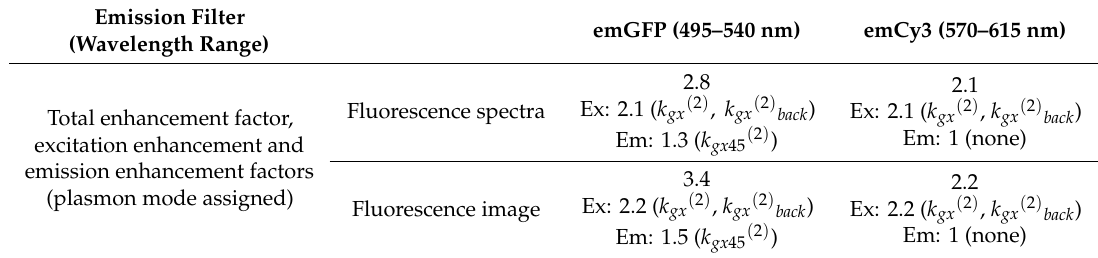
Table 7. Enhancement e ff ect of YG with exCFP for the 2D chip in the transmitted optical system.